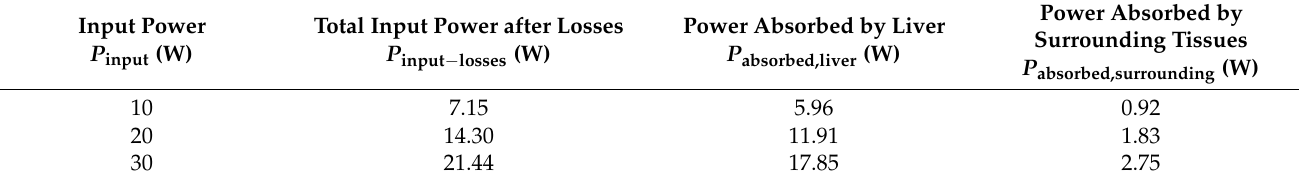
Table 4. Distribution of absorbed thermal energy.